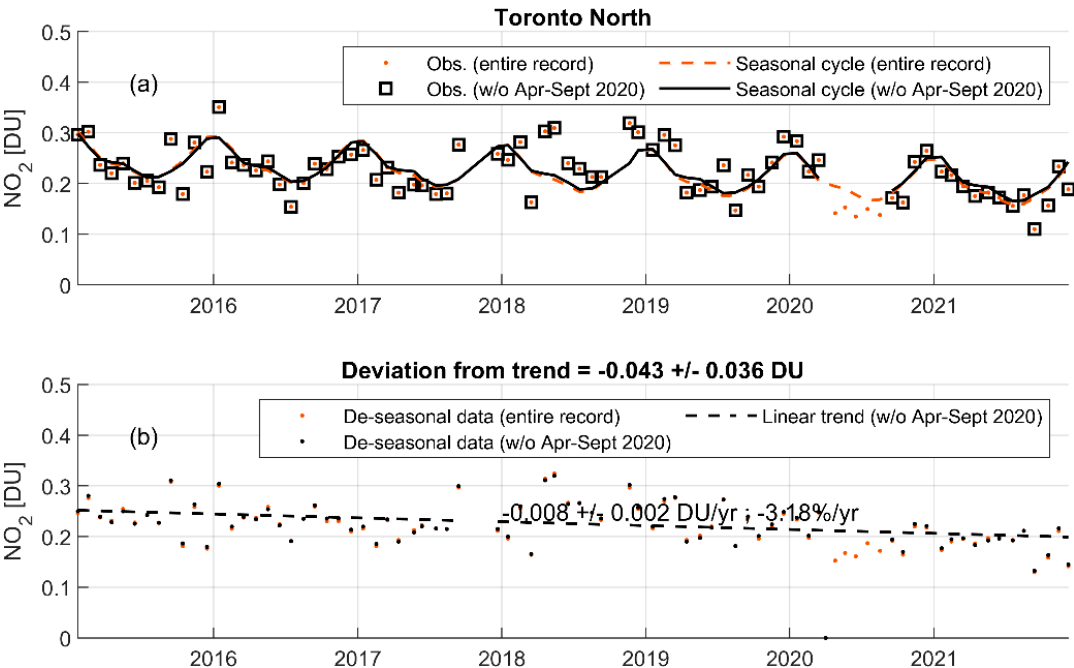
Figure A3. Pandora NO 2 tropospheric column fitting results from the statistical model at Downsview (i.e., NAPS Toronto North site). Red symbols represent data and fittings for the entire observation record. Black symbols represent data and fittings for the records without data from April to September 2020. Panel ( a ) shows the observations and fitted seasonal cycles; panel ( b ) shows the de-seasonal data and fitted linear trend.